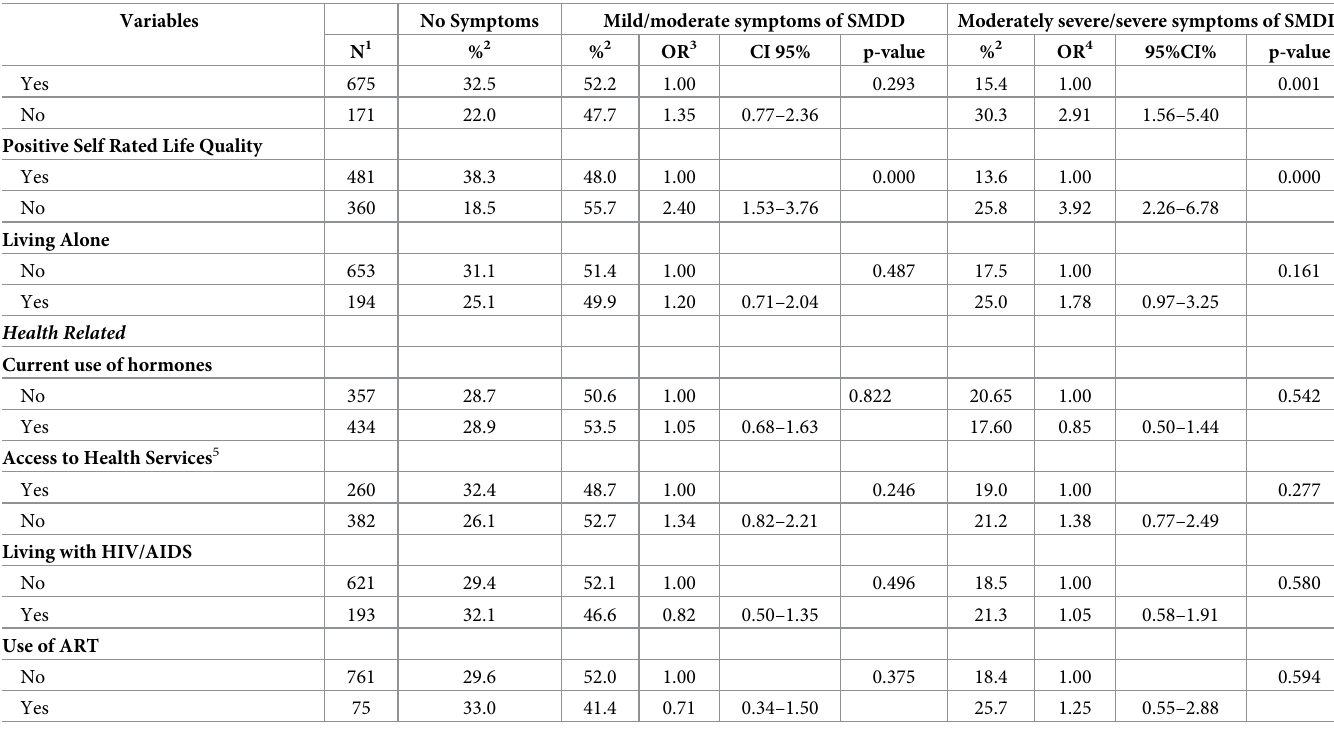
Table 2. Multivariate analysis of factors associated with symptoms of SMDD among transgender women in Northeast Brazil, 2017.